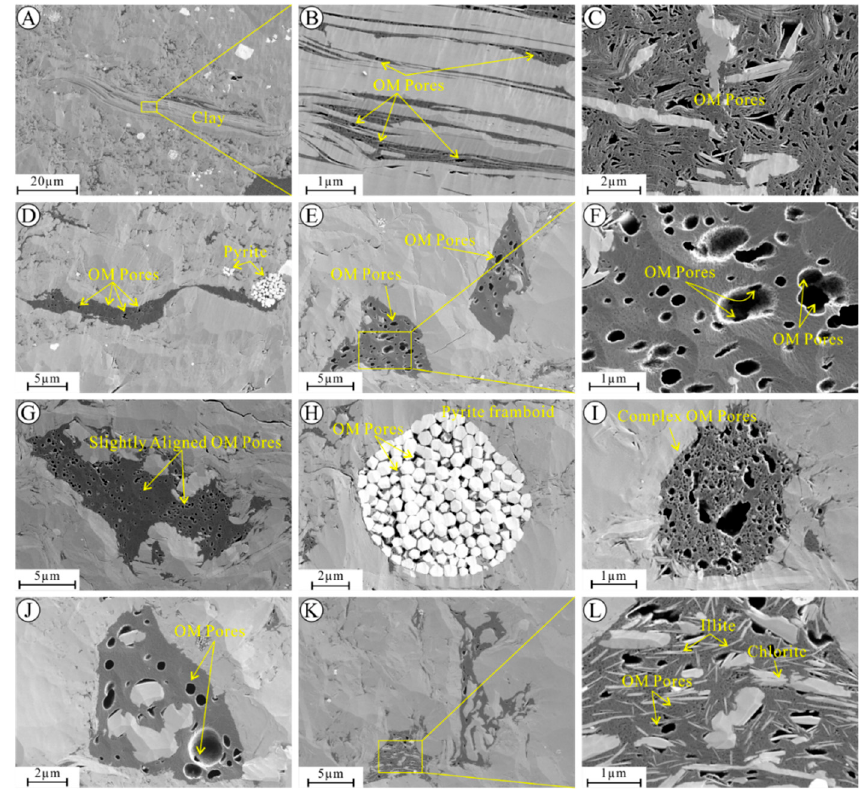
10 of 27 Figure 4. FE ‐ SEM images of microfracture in Longmaxi shale samples. ( A ) & ( B ) Microfracture without filling, Sample W205 ‐ 3; ( C ) & ( D ) Microfracture without filling, Sample W205 ‐ 3; ( E ) Microfracture partly filled with organic matter, Sample N213 ‐ 13; (F) Microfracture filled with organic matter, Sample N213 ‐ 13; ( G ) & ( H ) Microfracture filled with organic matter, Sample W205 ‐ 3; ( I ) Cleavage cracks within grain, Sample N213 ‐ 13. 4.2.4. Organic Matter Pores OM pores are intraP pores that are found within OM, which are the most important storage space for shale gas, especially in over maturation marine shales in South China [10,32,62,72]. Organic matter pores in the LM shales can be commonly found on FE ‐ SEM images (Figure 5). The characteristics of the OM pores are commonly controlled by the location of OM. Organic matter, which occurs between clay platelets, is generally distributed in long strips and nearly parallel to the clay sheets. OM pores within these OM are commonly irregular or elliptical (Figure 5A,B) with a relatively small pore size (mostly less than 100 nm). Some OM is mixed with clay minerals forming organic ‐ clay complex (Figure 5C). Organic ‐ clay complex is strongly deformed due to compaction. Pores within organic ‐ clay complex are extremely irregular with the pore sizes ranging from a few nanometers to several hundred nanometers (Figure 5C). Honeycomb pores or sponge ‐ like pores can be found within isolated massive organic matter or banded organic matter. Honeycomb pores have bubble ‐ like or elliptical cross sections. The pores within isolated OM are highly heterogeneous and vary greatly in pore size. In addition to the larger elliptic or bubble ‐ shaped pores, there are also smaller densely distributed needle ‐ like pores (Figure 5D–G,I). Some OM pores are nested with small cavernous pores (Figure 5E–J), forming a pore network, which greatly increases pore connectivity and has good storage capacity. A few OM pores are extended to each other forming a larger pore and